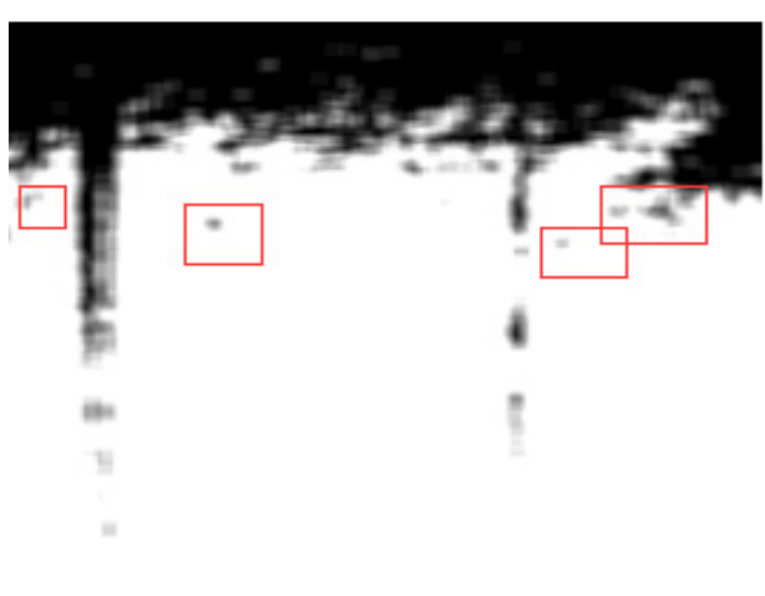
Figure 4. The relationship between accuracy and confidence in VGG16.